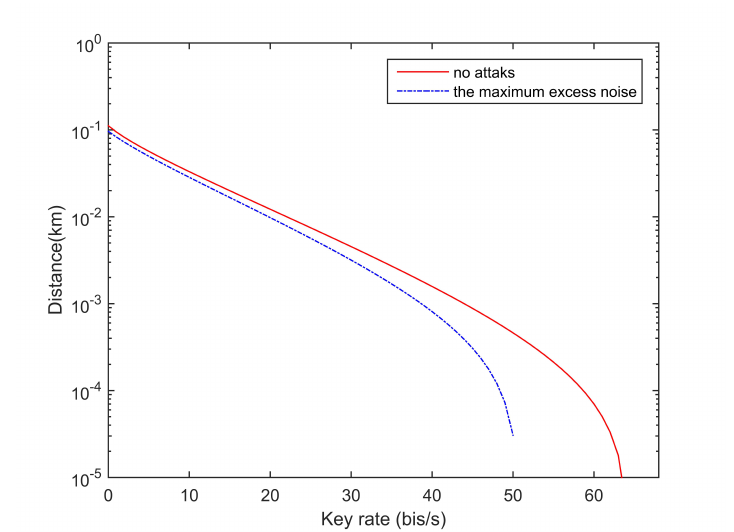
Figure 2. Change of secret key rate with transmission distance under different excess noise levels. The excess noise without attacks is set to 0.01, the maximum excess noise when the transmission distance is 50 km is